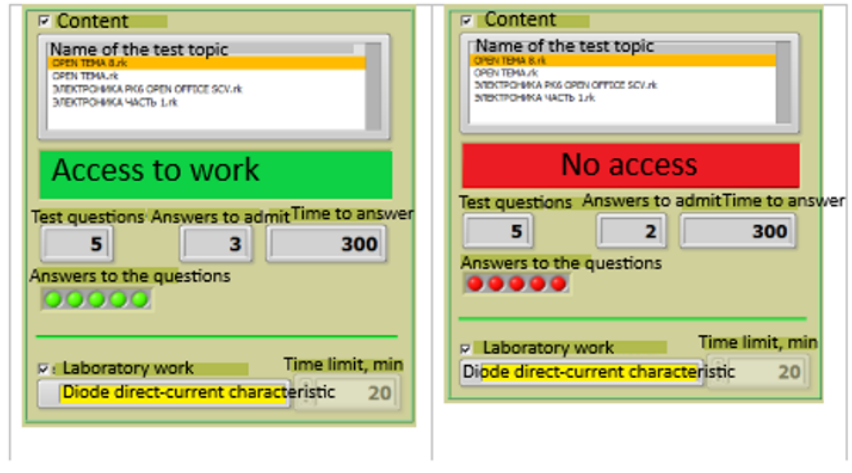
Fig. 9. An example of the practical work preliminary